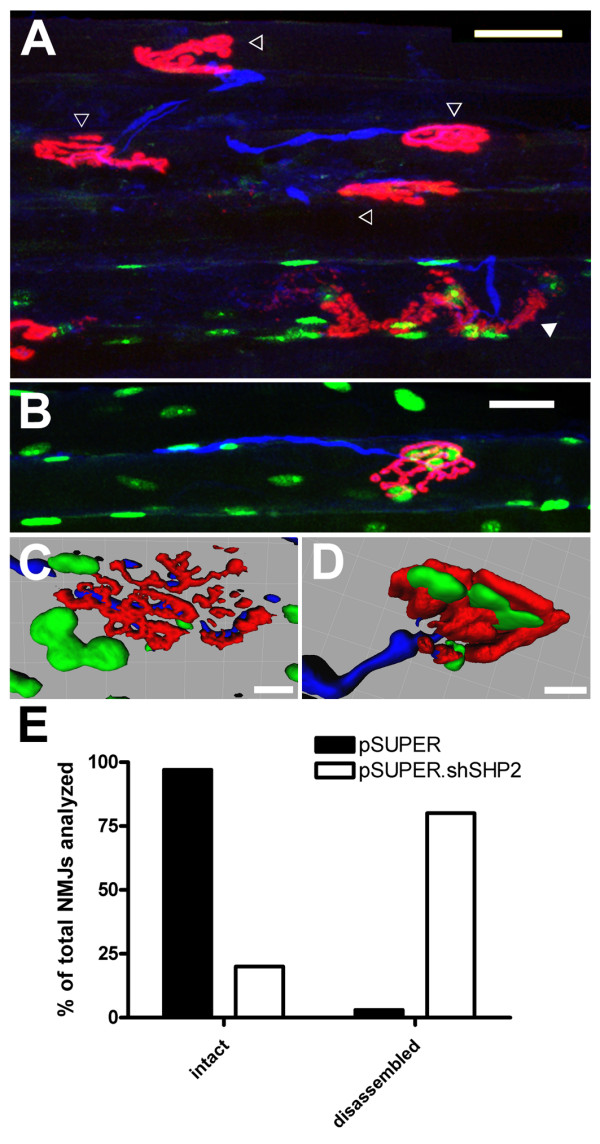
Electroporation of SHP-2 shRNA construct into soleus muscle of adult mice leads to disassembly of NMJs. Adult mice soleus muscles were electroporated in vivo with a mixture of pSUPER.shSHP2 and NLS-GFP constructs (A, C), or pSUPER vector and NLS-GFP as control (B, D). After six weeks muscles were dissected, whole mounts of fibers prepared and stained with rhodamine-α-BTX and a mixture of neurofilament and synaptophysin antibodies followed by Cy5 secondary antibody. NMJs were analyzed by confocal microscopy, whereby successfully electroporated muscle fibers were identified by the expression of NLS-GFP in myonuclei. (A) Expression of pSUPER.shSHP2 results in NMJ disassembly in GFP-positive myofibers (closed arrowhead). NMJs of GFP-negative fibers remain intact (open arrowheads). (B) Expression of control pSUPER vector and NLS-GFP has no effect on the NMJs. A three-dimensional reconstruction of a confocal image of a muscle electroporated with pSUPER.shSHP2 and NLS-GFP (C), or control pSUPER vector and NLS-GFP (D) shows details of the NMJs. (C) A 3D view from inside the muscle illustrates that expression of SHP-2 shRNA leads to disassembly of the NMJ, loss of the usual morphology and pretzel shape, and a resulting fragmented appearance of the NMJ, with the nerve becoming visible through the pretzel remnants. (D) In control electroporated muscle fibers, GFP-positive synaptic nuclei are located below the intact pretzel-shaped accumulations of AChRs and no nerve is visible through the pretzel. (E) The number of intact and disassembled NMJs is shown for control (pSUPER) vector and pSUPER.shSHP2 electroporated muscle fibers, as percentage of the total number of NMJs analyzed (total of 25 endplates from 3 mice for pSUPER and 15 endplates from 5 mice for pSUPER.shSHP2). Only endplates with synapse-associated nuclei expressing NLS-GFP were analyzed. Scale bars, 30 μm in A, B; 10 μm in C, D.